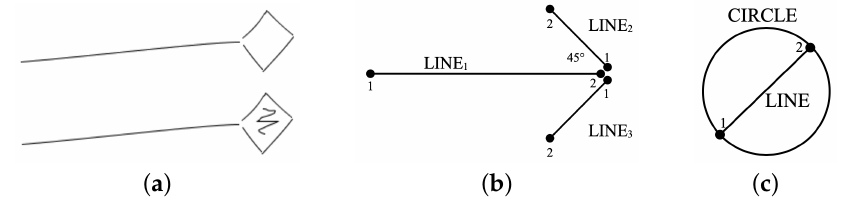
Figure 5. A sketched version of Aggregation and Composition symbols ( a ), Association symbol ( b ), and a temporal gesture ( c ) as described by the SkG grammar